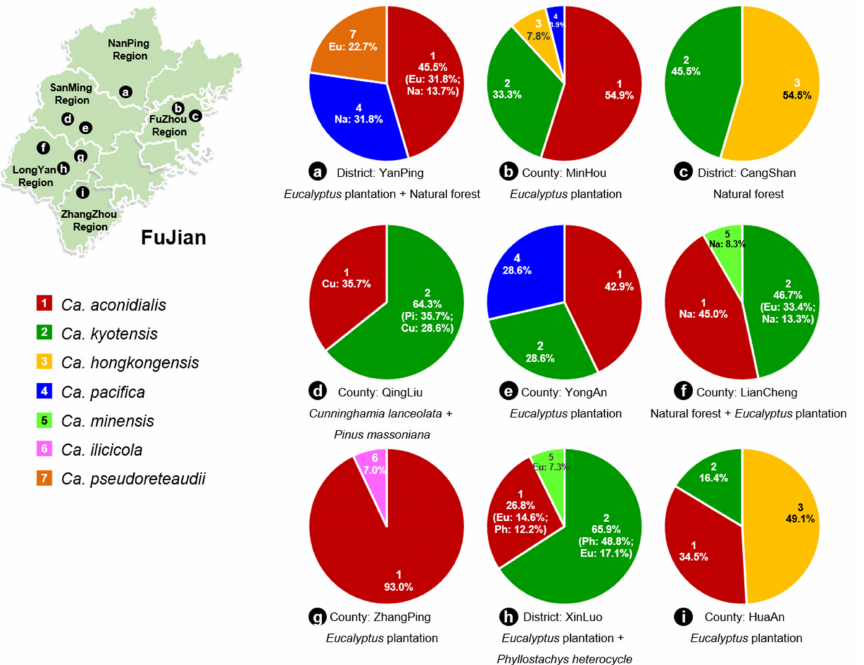
Figure 2. Calonectria species collected from nine counties (districts) in Fujian Province. ( a – i ). the percentage of each species in nine different counties (districts). Different species are indicated by numbers with different